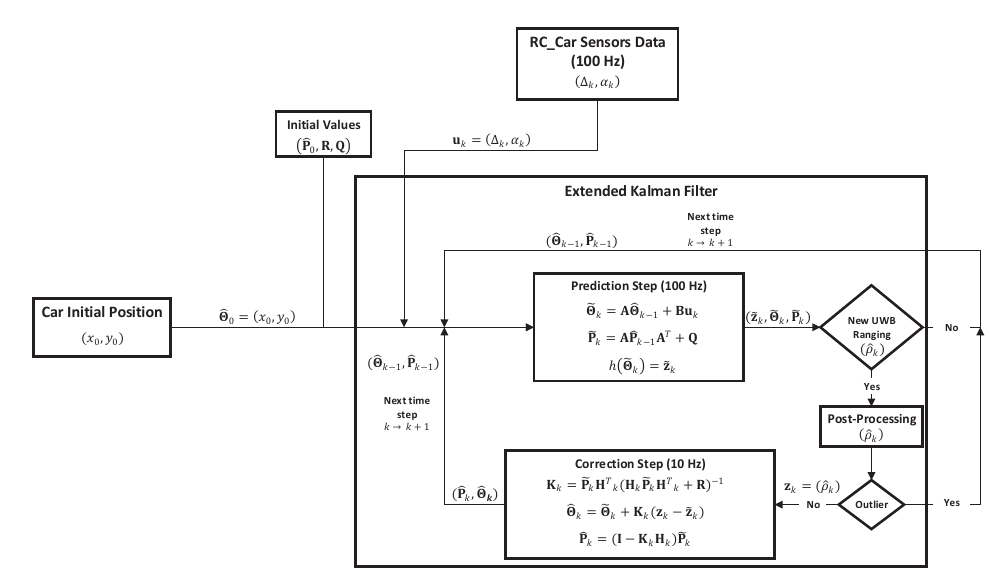
Figure 3. Representation of the proposed Extended Kalman Filter.